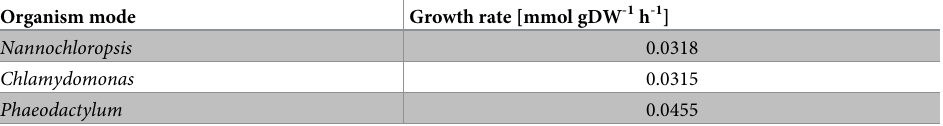
Table 1. Growth rates of the chloroplast model simulated in Nannochloropsis mode, Chlamydomonas mode and Phaeodactylum mode,